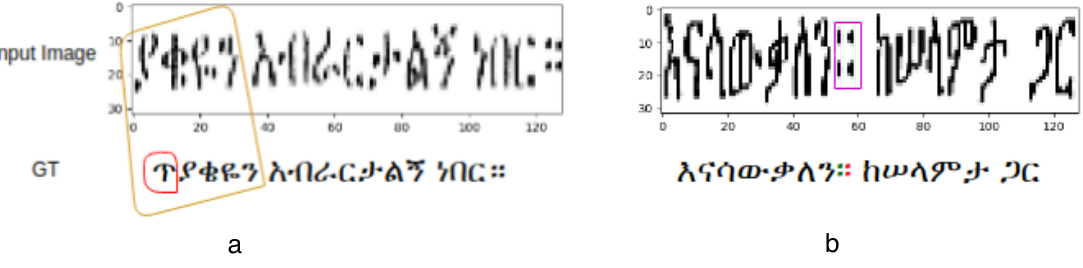
Figure 5. Samples with wrongly annotated images and GT from the test dataset. ( a ) Synthetic text-line image; the word marked with yellow rectangle is a sample mislabeled word where the first character ( µ ) in the GT, marked with a red circle, is missed in the input image but it exists in GT. ( b ) Printed text-line image; a punctuation mark called a full stop/period, bounded with a purple rectangle in the input image, is incorrectly labeled as two other punctuation marks called word separators, indicated by the green and red text colors in the GT.